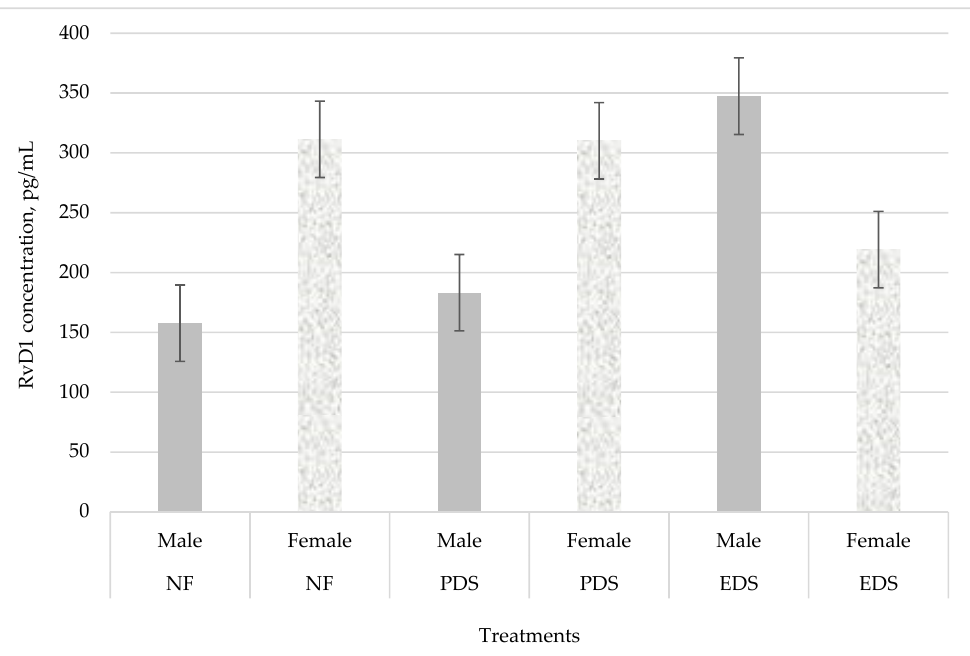
Figure 2. Effect of a fatty acid enriched diet during the last 50 days of gestation and offspring’s sex on plasma RvD1 concentrations at birth. Treatments of ewes supplemented with Ca salts of MUFA (PDS; EnerGII, Virtus Nutrition LLC, Corcoran, CA, USA.), PUFA (EDS; Strata G113, Virtus Nutrition LLC, Corcoran, CA, USA.) or no supplementation (NF) during the last 50 days of gestation (54 lambs, 3 dam treatments). Data are presented as the LSmean of the FA × Sex ( p = 0.05; standard error of the mean = 80.37). No difference ( p ≥ 0.31) for treatments or sex.